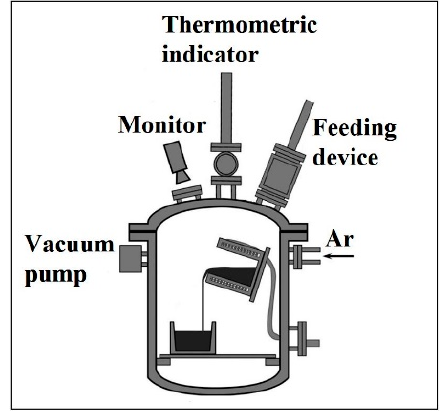
Figure 1. A schematic diagram of the experimental setup: a 30 kg vacuum induction furnace.